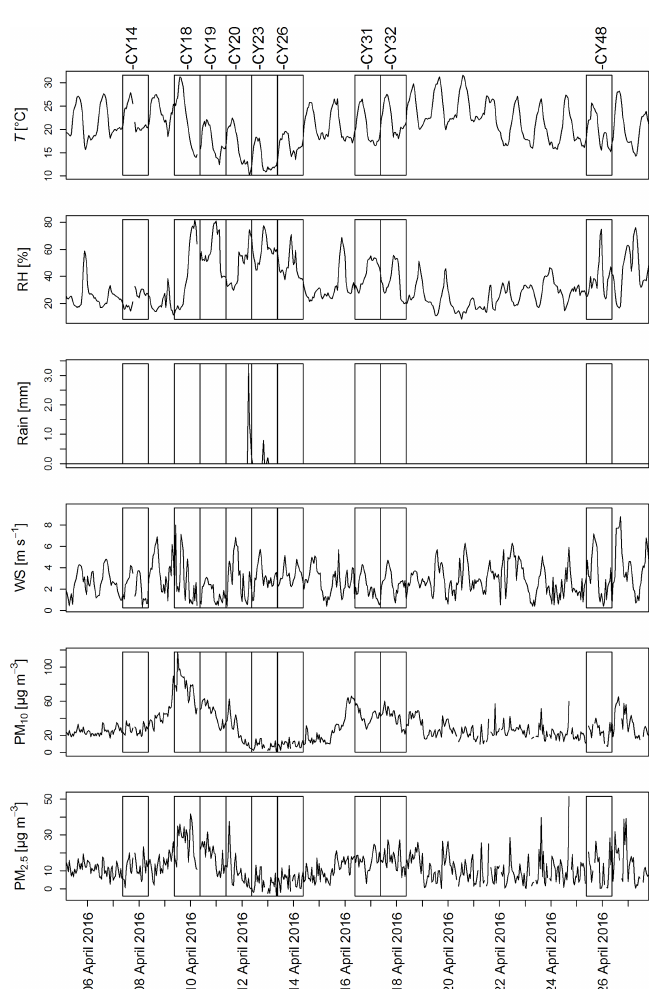
Figure A1. Meteorological conditions and aerosol mass concentrations: 1h averages of temperature ( T ), relative humidity (RH), rainfall (Rain), wind speed (WS), and aerosol mass concentrations of PM 10 and PM 2 . 5 during the sampling